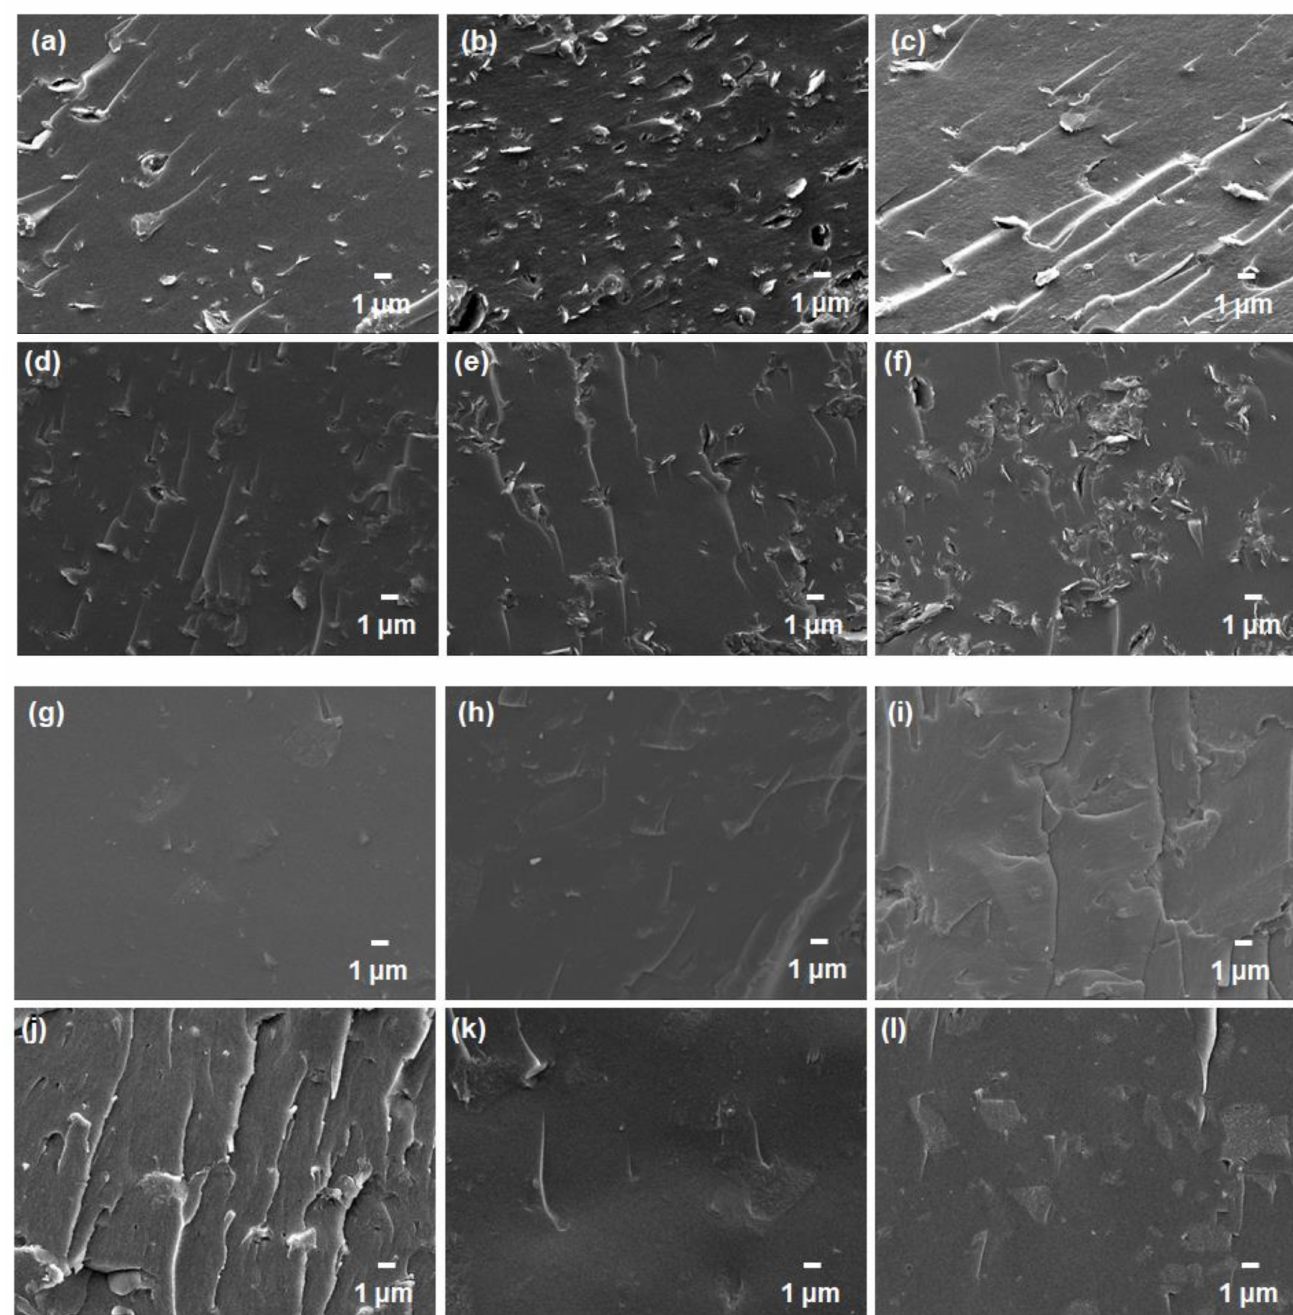
Figure 7. FESEM images of the mixed-matrix carbon molecular sieve membranes containing: ( a ) 5 wt %; ( b ) 10 wt % and ( c ) 15 wt % GO in Matrimid ® 5218; ( d ) 5 wt %; ( e ) 10 wt % and ( f ) 15 wt % GO in ODPA-TMPDA; ( g ) 5 wt %; ( h ) 10 wt % and ( i ) 15 wt % YP-50F in Matrimid ® 5218; ( j ) 5 wt %; ( k ) 10 wt % and ( l ) 15 wt % YP-50F in